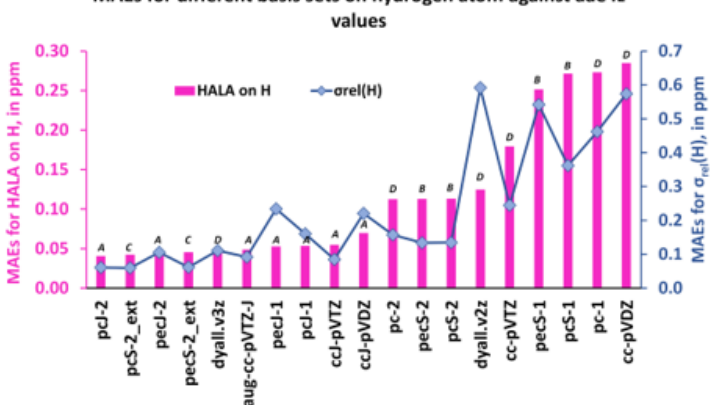
Figure 12. The MAEs for the HALA effect on the proton shielding constants and that of the proton shielding constants of molecules 1 – 11 were calculated with different basis sets on light atoms against the values obtained with the dyall.aae4z basis set on all atoms.